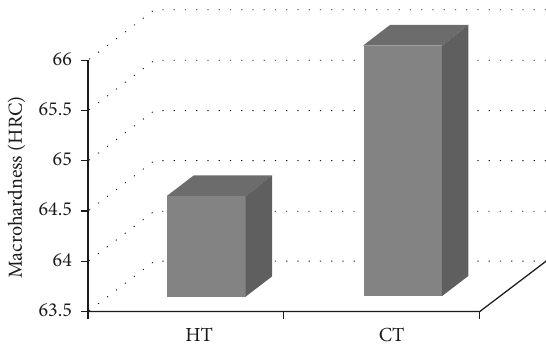
Figure 5: Macrohardness test results of the AISI M2 tool